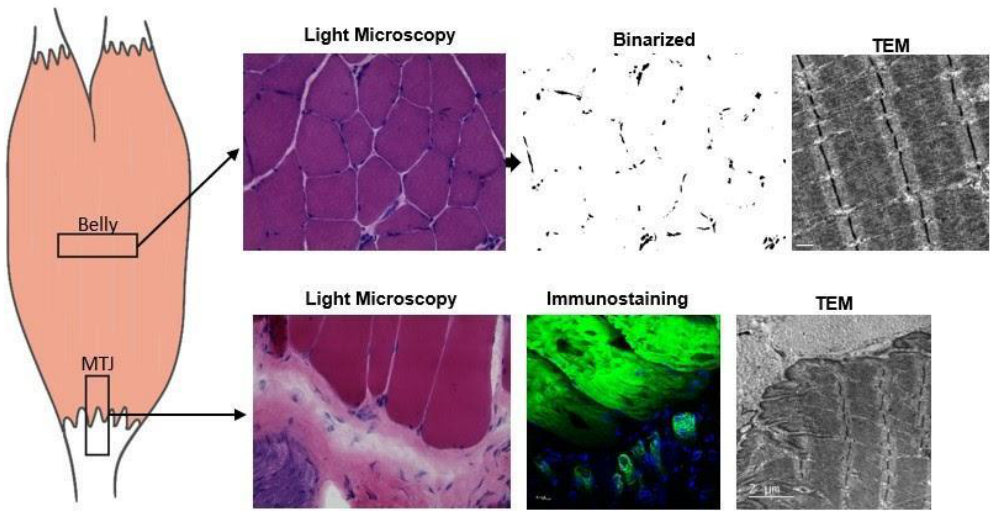
Figure 5. Illustrative image of the gastrocnemius muscle of Wistar rats, with the demarcation of regions (squares) from where the sections and samples of the muscle belly and myotendinous junction (MTJ) regions were performed. The samples of muscle belly collected in transverse sections were processed for the light microscopy technique and stained with hematoxylin-eosin (HE) and then binarized using the ImageJ software for cell nuclei identification (magnification: 400 × ); the samples of muscle belly collected in longitudinal sections were analyzed using the transmission electron microscopy (TEM) technique to identify sarcomeres in series (magnification: 15,000 × ). The samples of the myotendinous region collected in longitudinal sections were processed for light microscopy technique and stained with HE (magnification: 400 × ), and immunostaining with Alexa Fluor™ 488 Phalloidin and DAPI (magnification: 1000 × ); the TEM technique was used to identify the MTJ ultrastructures (magnification: 10,000 ×